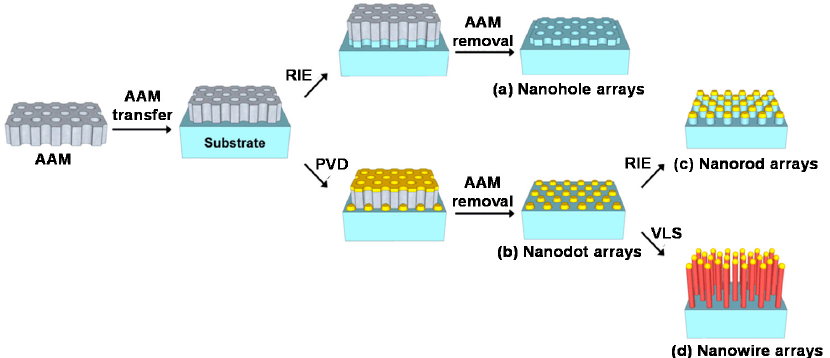
Figure 6. Schematic diagrams on the fabrication of well-oriented nanostructured arrays of: ( a ) nanoholes; ( b ) nanodots; ( c ) NRs; and ( d ) NWs using an AAM template. Reprinted with permission from [33]. Copyright 2014 American Chemical Society.